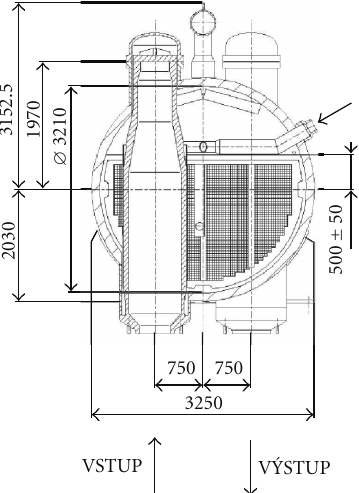
Figure 2: VVER-440 (Bohunice) steam generator cross-section A- A, Bohunice innovation